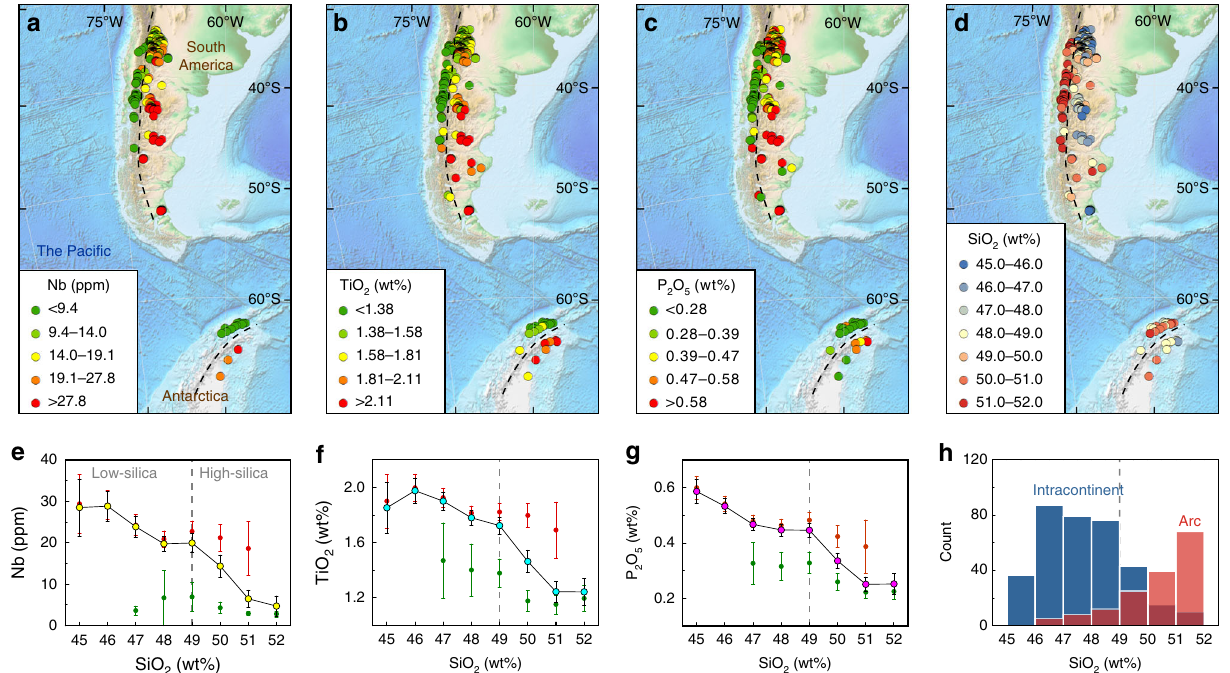
Fig. 1 Fractionation of Nb, Ti and P-SiO 2 of ma fi c rocks from South America. a – d Locations and concentrations of Nb (ppm), TiO 2 (wt%), P 2 O 5 (wt%), and SiO 2 (wt%), respectively, of ma fi c rock samples (0 – 5 Ma ages) from the southern Andes of South America and the Antarctic Peninsula. The black dashed lines divide the rock samples into arc (west) and continental (east) groups. Background relief maps are downloaded from NOAA website (https://www. ngdc.noaa.gov/) 61 . e – g Nb-SiO 2 , TiO 2 -SiO 2 , and P 2 O 5 -SiO 2 compositional trends, respectively, of ma fi c rocks within the map area. The circles with yellow, cyan, and magenta in fi lls denote the average Nb, TiO 2 , and P 2 O 5 concentrations, respectively, of all ma fi c rocks within the map area. Error bars denote two standard errors of the means (s.e.m.). The gray vertical-dashed line shows a proposed subdivision between low-silica (45 – 49 wt% SiO 2 ) and high-silica (49 – 52 wt% SiO 2 ) ma fi c rocks. h Histograms showing the frequency of arc (red) and intracontinental (blue) ma fi c